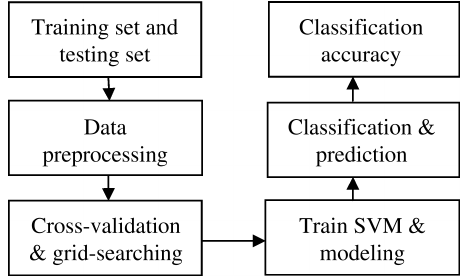
Fig. 2. The °ow chart of SVM. Classi¯cation process includes training and testing set selection, data preprocessing, par- ameter optimization, SVM modeling, classi¯cation judgment and solving of classi¯cation accuracy.